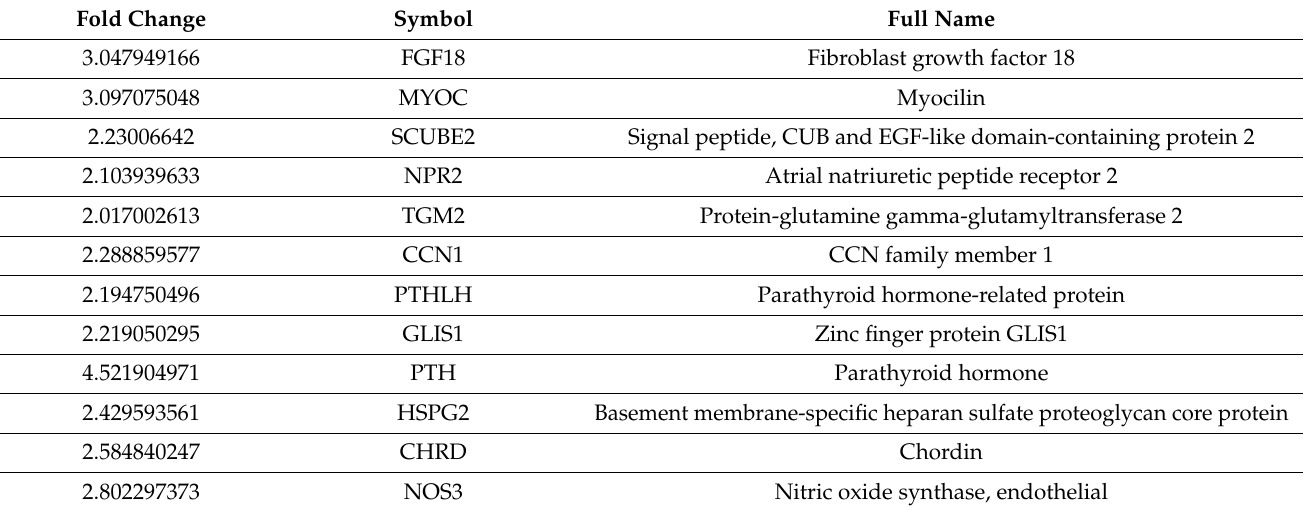
Table 5. Genes upregulated in the angiogenesis and regulation of cell differentiation pathways asso- ciated with ossification and bone development in “biological process” terms with their fold increase.